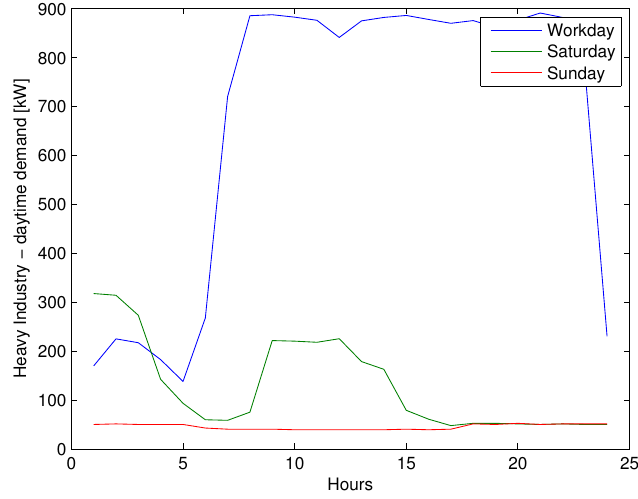
Figure 8. Heavy Industry—Daytime curves for three representative days of the